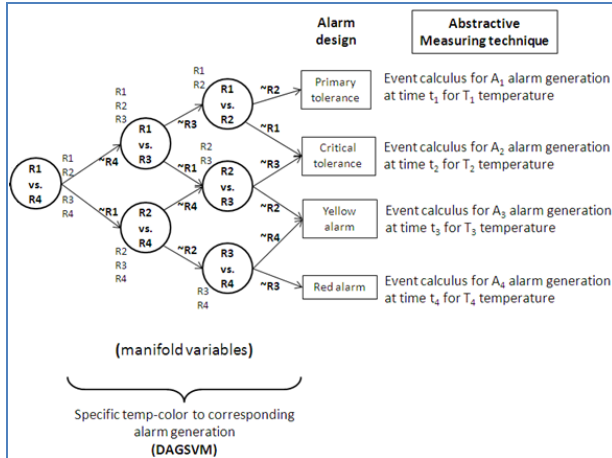
Figure 3. DAGSVM with event-calculus